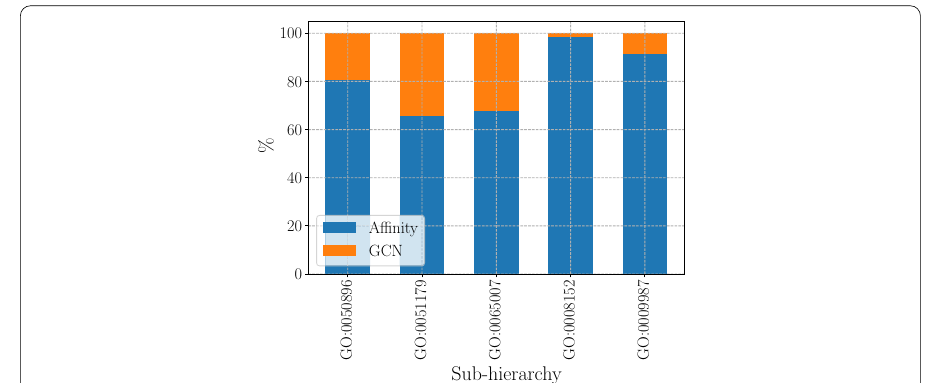
Fig. 9 Distribution of the filtered features from J G and J F for the global method per sub-hierarchy